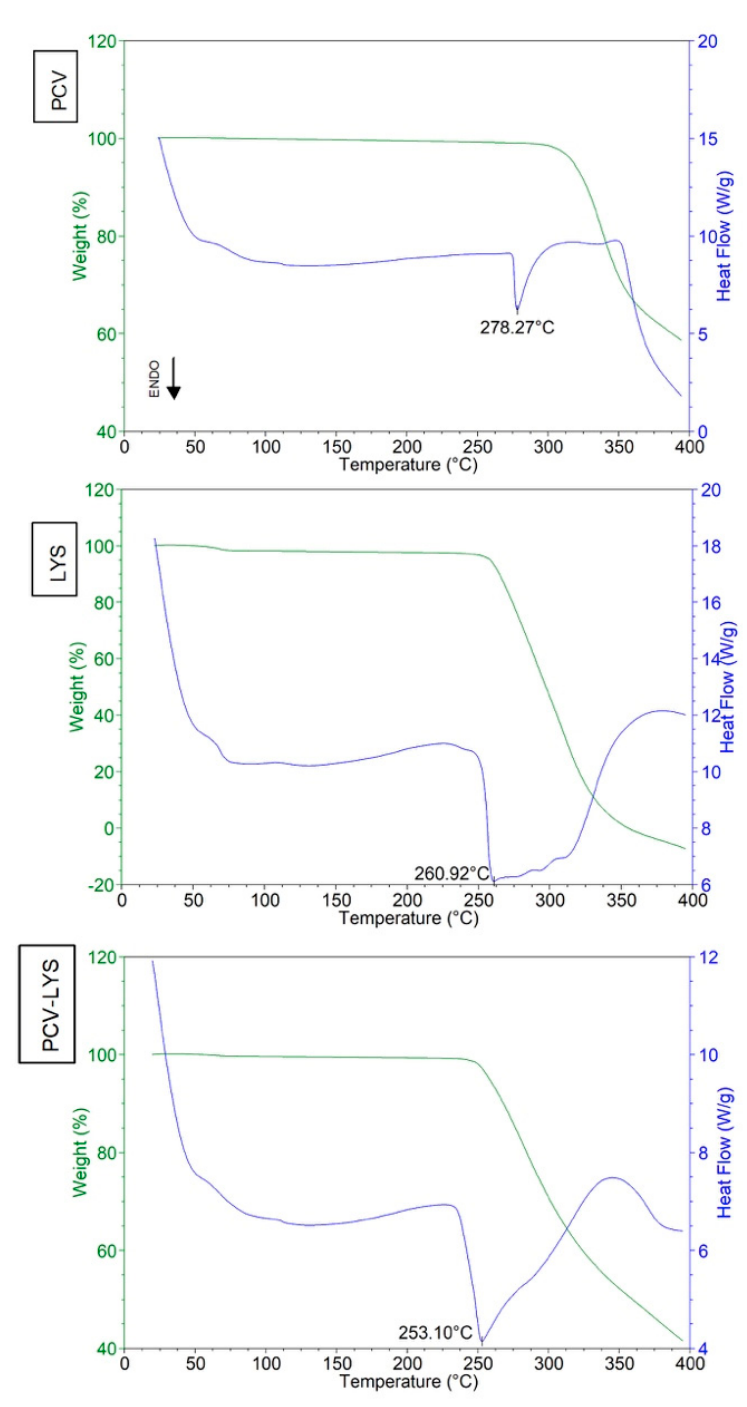
Figure 2. Di ff erential scanning calorimetry (DSC) curves of PCV, LYS, and PCV-LYS Figure 2. Differential scanning calorimetry (DSC) curves of PCV, LYS, and PCV-LYS mixture.